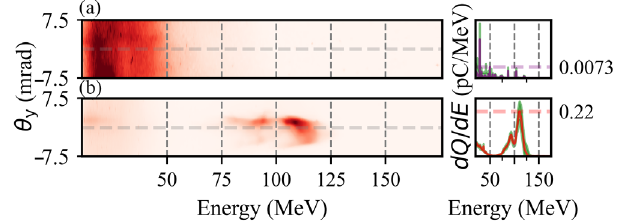
FIG. 6. Same as Fig. 5 for laser focus at z ¼ 0 mm with three consecutive shots included in the standard deviation.